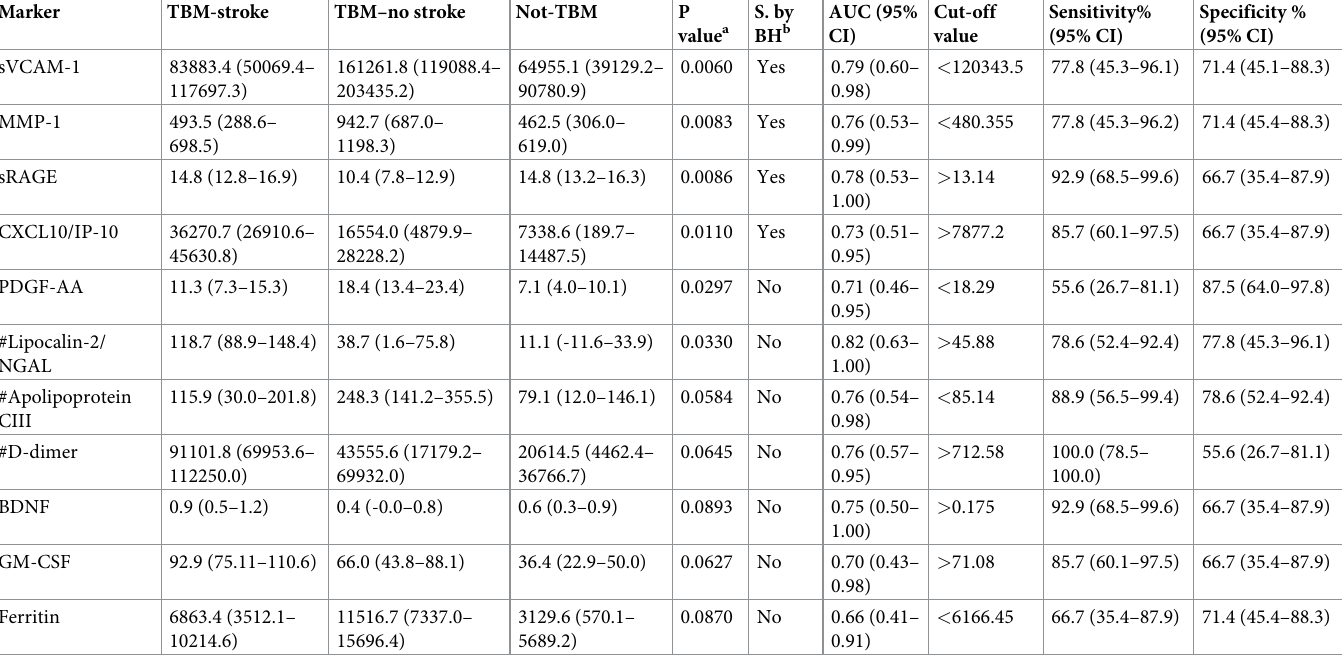
with TBM Data for all the CSF host proteins in children with TBM were analysed with GDA, regardless of HIV status, for investigation of combinations of proteins with optimal performance for indication of stroke. The most optimal model was obtained with a combination of four pro- teins, namely vascular endothelial growth factor (VEGF)-A, complement C5a, Complement factor 1, and BDNF. This four-protein biosignature indicated stroke among children with TBM with AUC of 0.98 (95% CI, 0.95–1.00), associated to sensitivity of 92.9% (95% CI, 66.1%- 99.8%) (13/14) and specificity of 88.9% (95% CI, 51.8%-99.7%) (8/9). The positive predictive value (PPV) and negative predictive value (NPV) of the biosignature were 92.9% (95% CI, Table 2. Expression of CSF host protein biomarkers amongst study participants with TBM and stroke/no stroke at admission, and utility of individual CSF host protein biomarkers to indicate stroke in TBM patients. The mean values shown (95% confidence intervals in brackets) are the least square (LS) means. Markers showing significant differences (p-value < 0.05) or trends (0.05 < p-value � 0.09) between the TBM patients with stroke and no stroke are shown. The differences in the concentra- tions of all other host markers are shown in S2 Table. #reported in ng/ml, all other markers are reported in